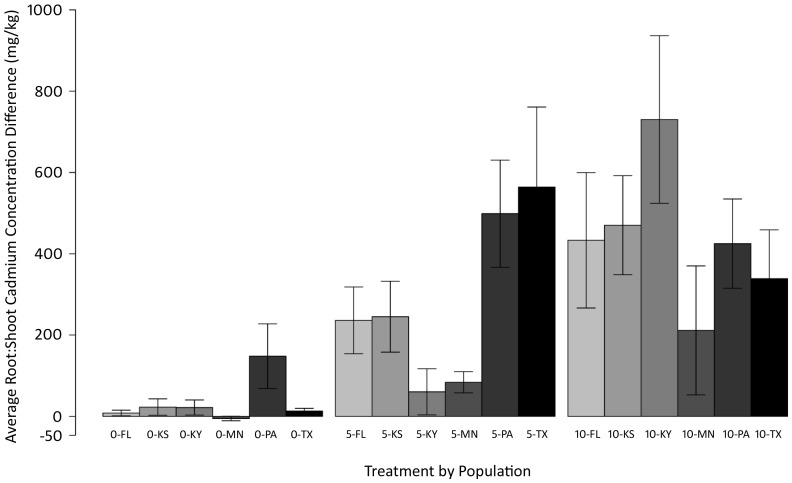
Root and shoot cadmium accumulation.Average difference in root to shoot cadmium accumulation for each of the six populations of Chamaecrista fasciculata in response to elevated soil cadmium levels. A positive value indicates that plants in that group accumulated more cadmium in their roots than in the shoots and a negative value indicates the opposite is true. Treatment levels (0, 5, 10) are in mg/kg.